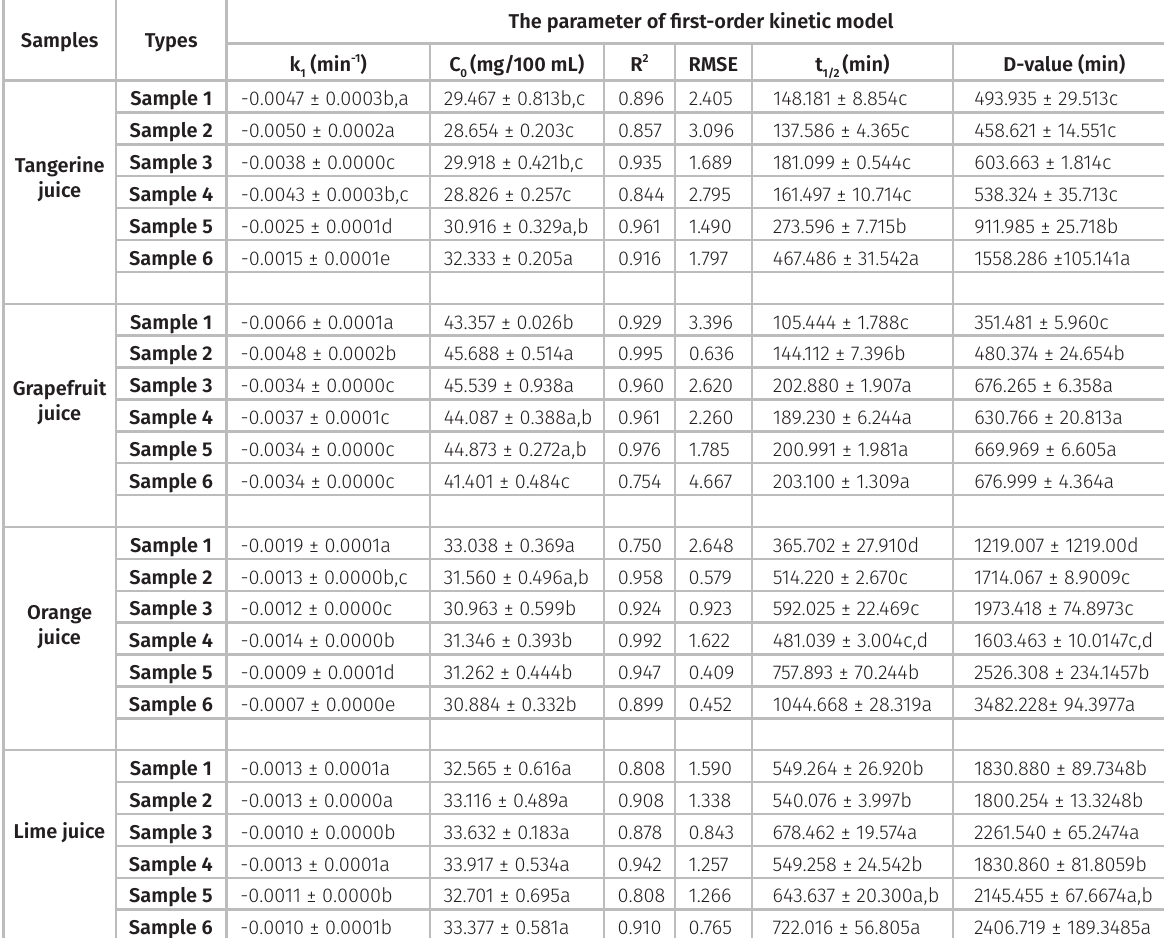
Table I. Kinetic parameters of the first-order kinetic model for vitamin C degradation in fresh home-made citrus juices during